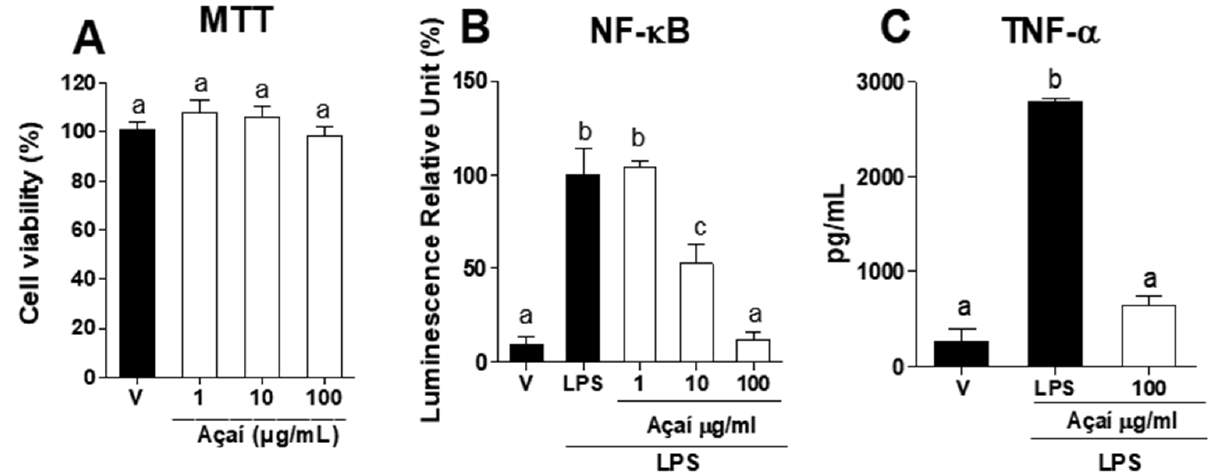
Figure 4. The inhibitory activity of the optimized açaí meal extract on NF- κ B activation and TNF- α levels. (A) Viability of macrophages exposed to the extract at 1, 10, or 100 µg ∙ mL − 1 . (B) NF- κ B acti- vation in cells pretreated with the extract at 1, 10, or 100 µg ∙ mL − 1 after stimulation with lipopolysac- charide (LPS) (10 ng ∙ mL − 1 ) for 4 h. (C) TNF- α levels detected in the supernatant of cultures pre- treated with the extract at 100 µg ∙ mL − 1 after stimulation with LPS (10 ng ∙ mL − 1 ) for 4 h. The data were expressed as mean ± SEM, n = 4. V — vehicle. Different letters indicate significant statistical differ- ences ( p < 0.05).